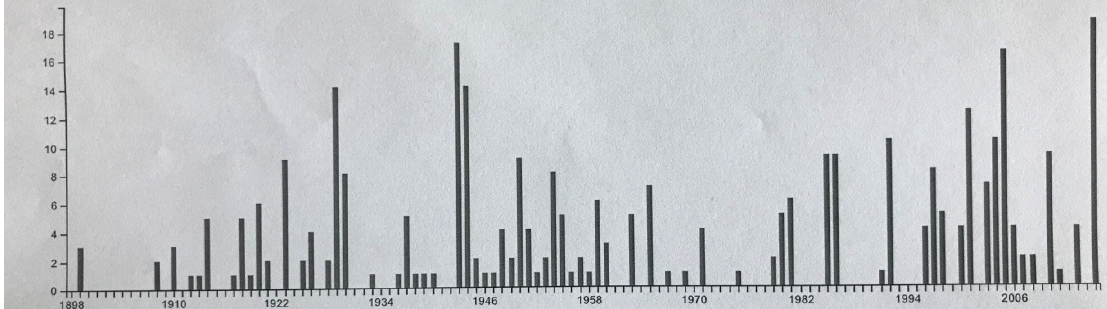
Figure 6. The hottest days in a year in Catania from 1900 to today.